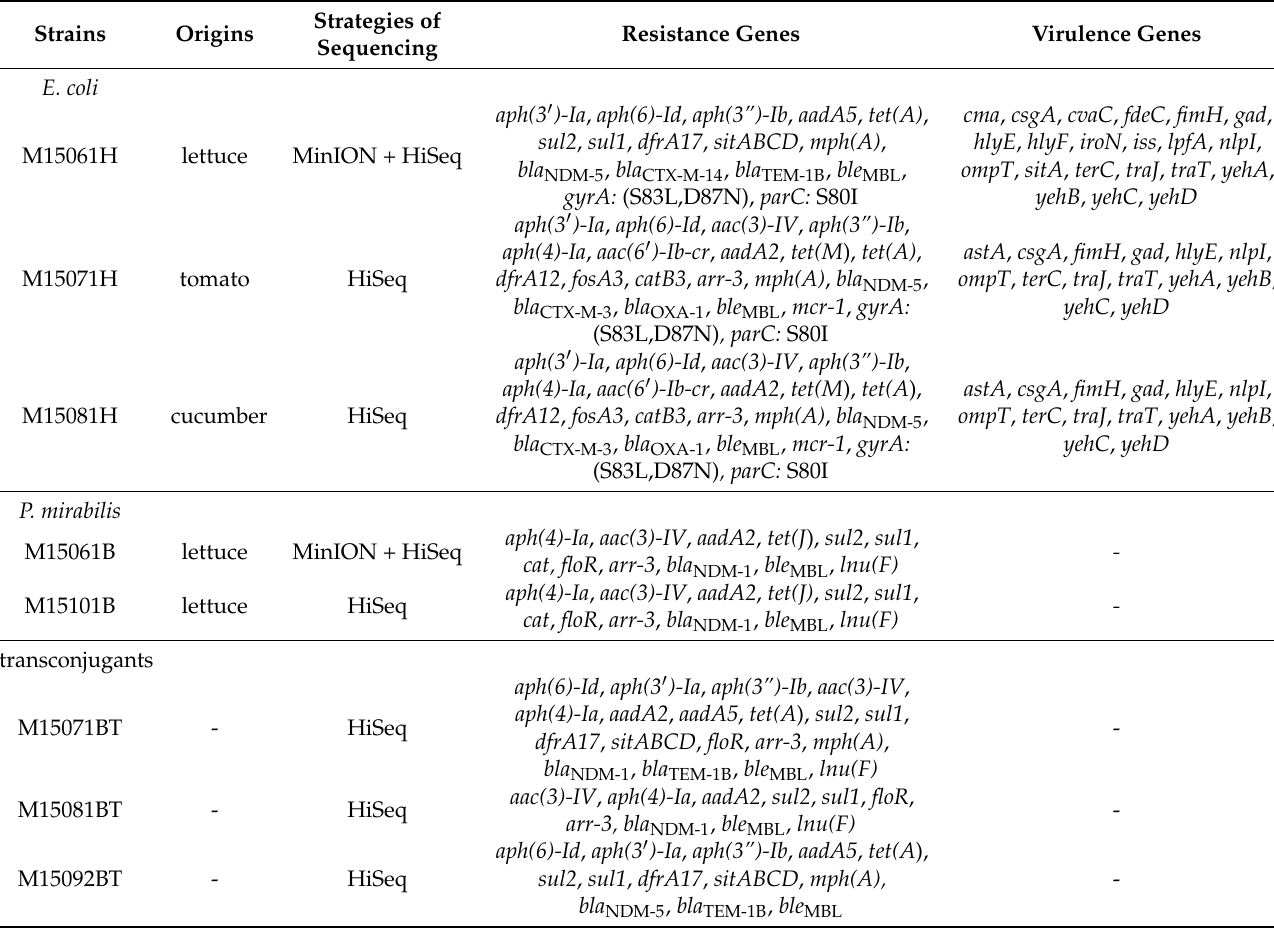
Table 3. Antimicrobial resistance genes of obtained isolates from WGS